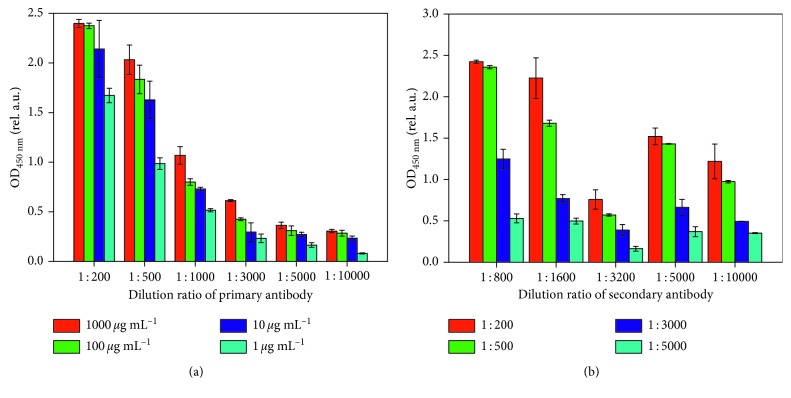
ELISA titration results in different conditions. (a) The dilution ratio of anti-keratin primary antibody is 1 : 200, 1 : 500, 1 : 1,000, 1 : 3,000, 1 : 5,000, and 1 : 10,000, while the concentration of keratin is 1,000 μg/mL, 100 μg/mL, 10 μg/mL, and 1 μg/mL, respectively. (b) The secondary antibody dilution ratio is 1 : 800, 1 : 1,600, 1 : 3,200, 1 : 5,000, and 1 : 10,000, while the anti-keratin primary antibody dilution ratio is 1 : 200, 1 : 500, 1 : 3,000, and 1 : 5,000, respectively. Each column of the figure represents the mean ± SD (standard deviation) of n=5 assays.